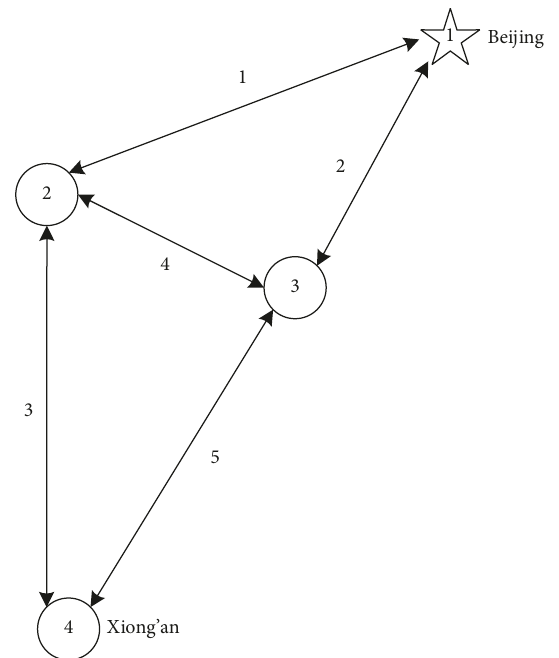
Figure 2: The transport network connecting Beijing and Xiong’an. Table 2: Link parameters of the transport network.